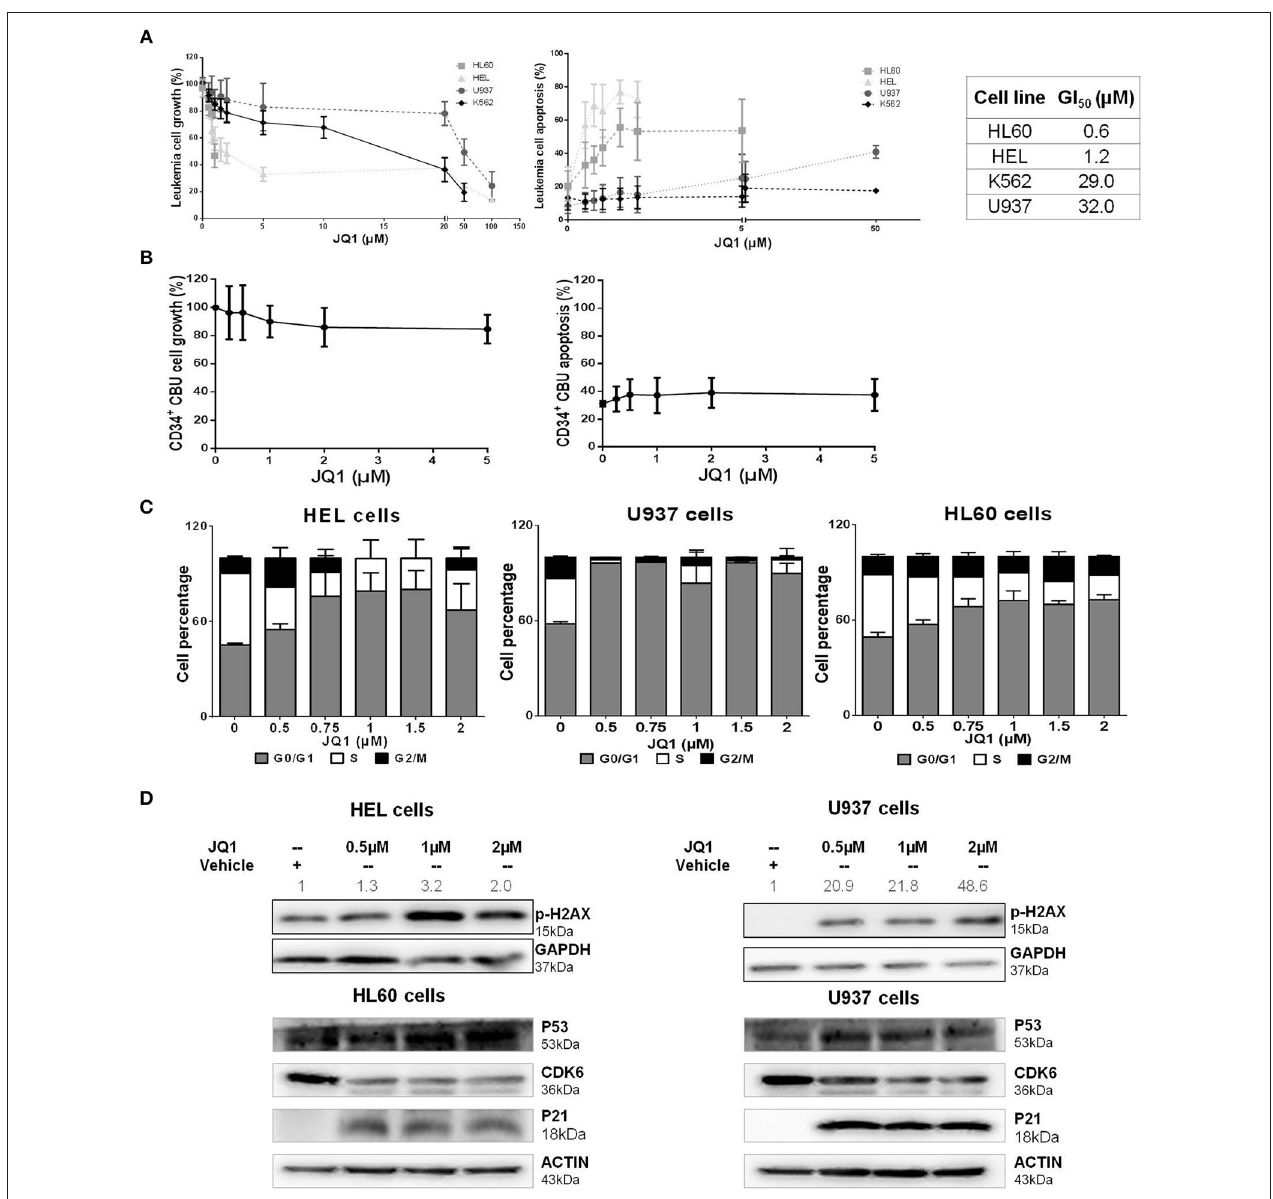
FIGURE 2 | JQ1, a BRD4 inhibitor, reduces cell viability, induces apoptosis and cell cycle arrest of leukemia cell lines, with variable drug sensitivity. (A) Cell viability and apoptosis were determined by MTT assays and flow cytometry after 48h of JQ1 treatment and growth inhibition (GI 50 ) of four leukemia cell lines (HL60, HEL, K562, and U937). GI 50 values determined from at least five independent experiments, by non-linear curve fitting to a sigmoid dose-response model; (B) Treatment of CD34 + cells from cord blood units (CBU) with increasing doses of JQ1 showed no significant cell viability reduction or apoptosis induction in that order; (C) Cell cycle phases were detected by flow cytometry. The cell lines tested are indicated in the graph. Results are shown as the percentage of total cells and bars represent increasing doses of JQ1. Graph bars represent a minimum of 6 independent experiments. (D) Western blotting analysis of total cell extracts from HEL, HL60, and U937 cells after 48h of treatment with JQ1. The membrane was blotted anti-pH2AX (15 kDa), P53 (53 kDa), CDK6 (36 kDa), P21 (18 kDa), and for GAPDH (37 kDa) or ACTIN (43 kDa) as a control for equal sample loading, and developed with the ECL Western Blotting Analysis System. Densitometry was performed and the ratio of p-H2AX vs. GAPDH compared with the normalized value of control is shown. Western blot figures are representative of all experiments performed. All bar graphs represent mean ± SD of at least five independent experiments.